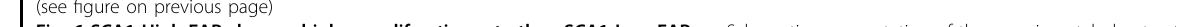
Fig. 6 SCA1-High-FAPs have a higher proliferation rate than SCA1-Low-FAPs. a Schematic representation of the experimental plan to study mdx FAP cell states proliferation rate in vitro. Collected samples were immunolabelled for Ki-67 and nuclei were counterstained with Hoechst 33342 ( n = 4). b Growth curve showing the number of nuclei per fi eld. c Plot representing the percentage of Ki-67 positive nuclei per fi eld. d Doubling time of FAP cell states calculated using the fi rst three days of exponential growth. Student ’ s t test was applied to determine statistical signi fi cance. e Experimental plan applied to investigate cell states proliferation in vivo. EdU at the concentration of 40 mg/kg was injected into the peritoneum of mdx mice. After 24 h mice were sacri fi ced and EdU incorporation was studied by fl ow cytometry. f Bar plot showing the percentage of FAP cell states in proliferating FAPs ( n = 5). g Gating strategy to evaluate EdU incorporation. For the unstained sample and FMO controls see Supplementary Fig. 7b, c. Data are presented as mean ± SEM. Statistical analysis was performed using Two-way ANOVA for the in vitro experiment and Student ’ s t test for the in vivo experiment. * p ≤ 0.05, ** p ≤ 0.01, **** p ≤